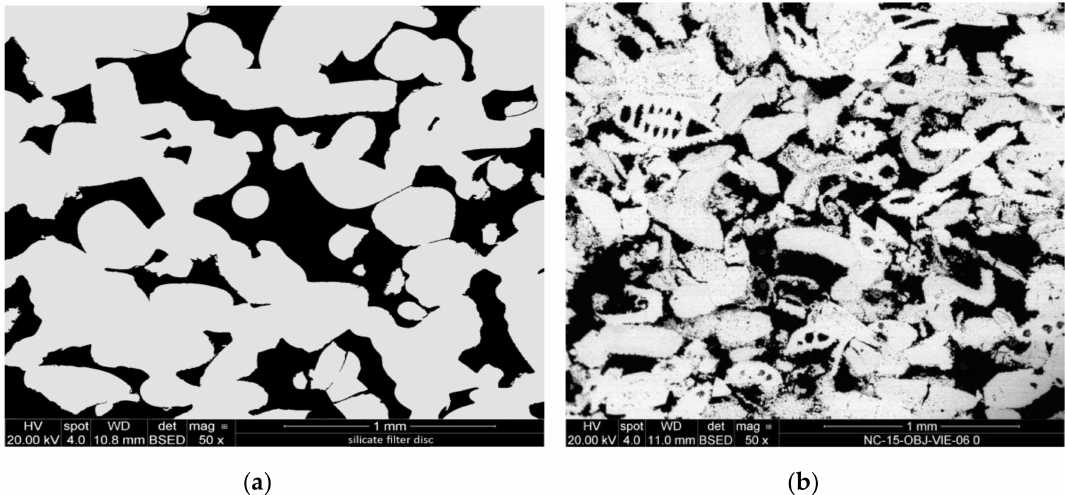
Figure 1. SEM-backscattered electron (BSE) micrographs of the cross-sections of: ( a ) silicate glass disc; ( b ) Au detrital